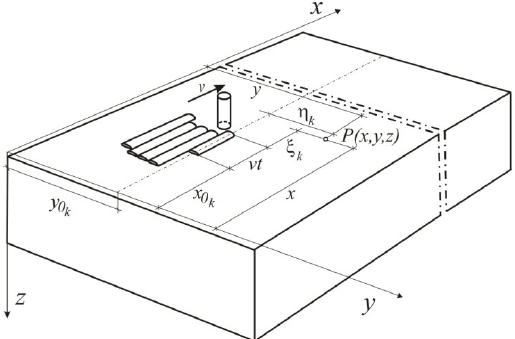
Figure 6. Scheme for describing the temperature field during multi ‐ pass surfacing.